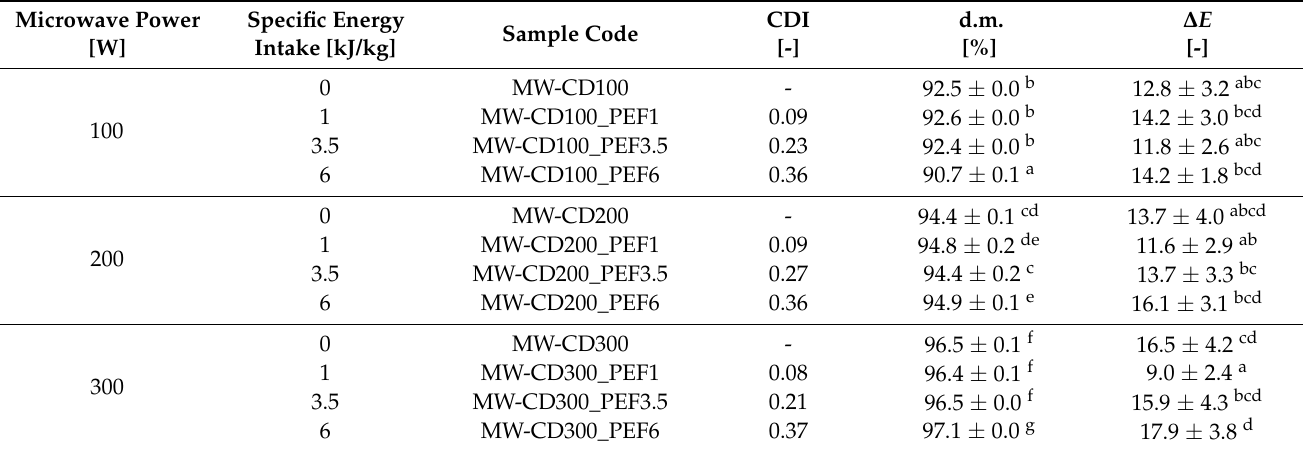
Table 2. Values of CDI (cell disintegration index), dry matter content (d.m.), and ∆ E (total colour difference) of obtained dried